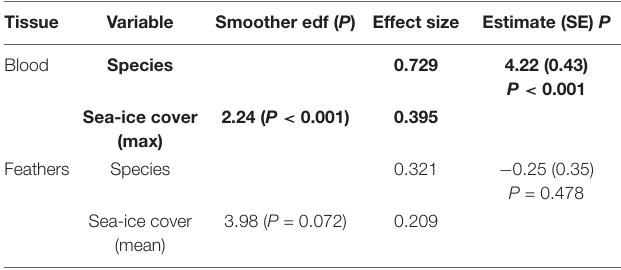
TABLE 6 | Generalized Additive Model (GAM) results for tracked individuals, separately for blood and feathers, as a function of species and sea ice